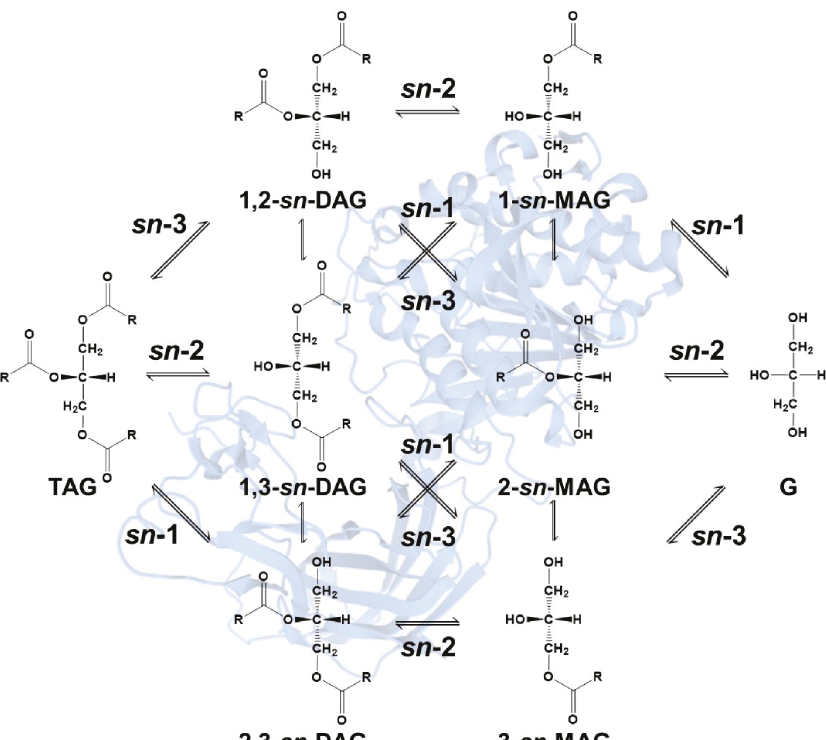
Figure 4: Lipase-catalyzed hydrolysis of a homogeneous prochiral triacylglycerol (TAG). From TAG, not only regioisomeric/enantiomeric diacylglycerols (DAG) but also monoacylglycerol (MAG) can be produced in accordance with the selectivity of lipase. Nonenzymatic acyl migrations are represented by vertical arrows between DAGs and MAGs. R fatty acid acyl moiety; G,